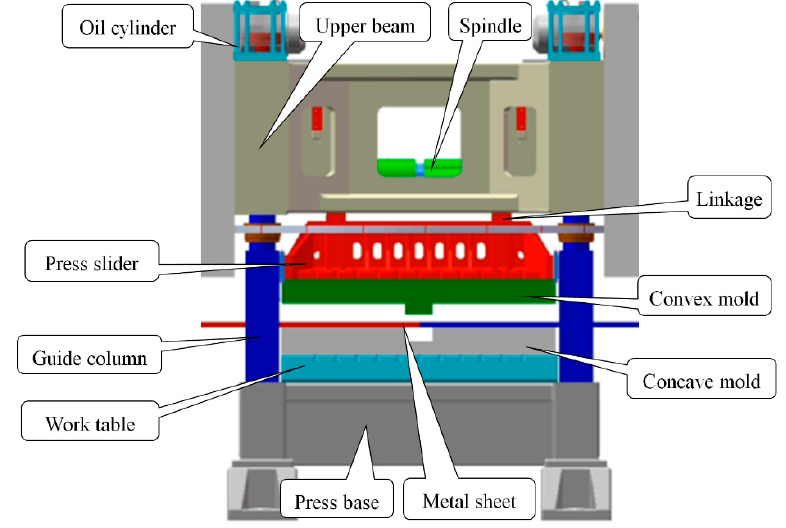
Figure 3. Schematic of the high-speed press and matching molds.